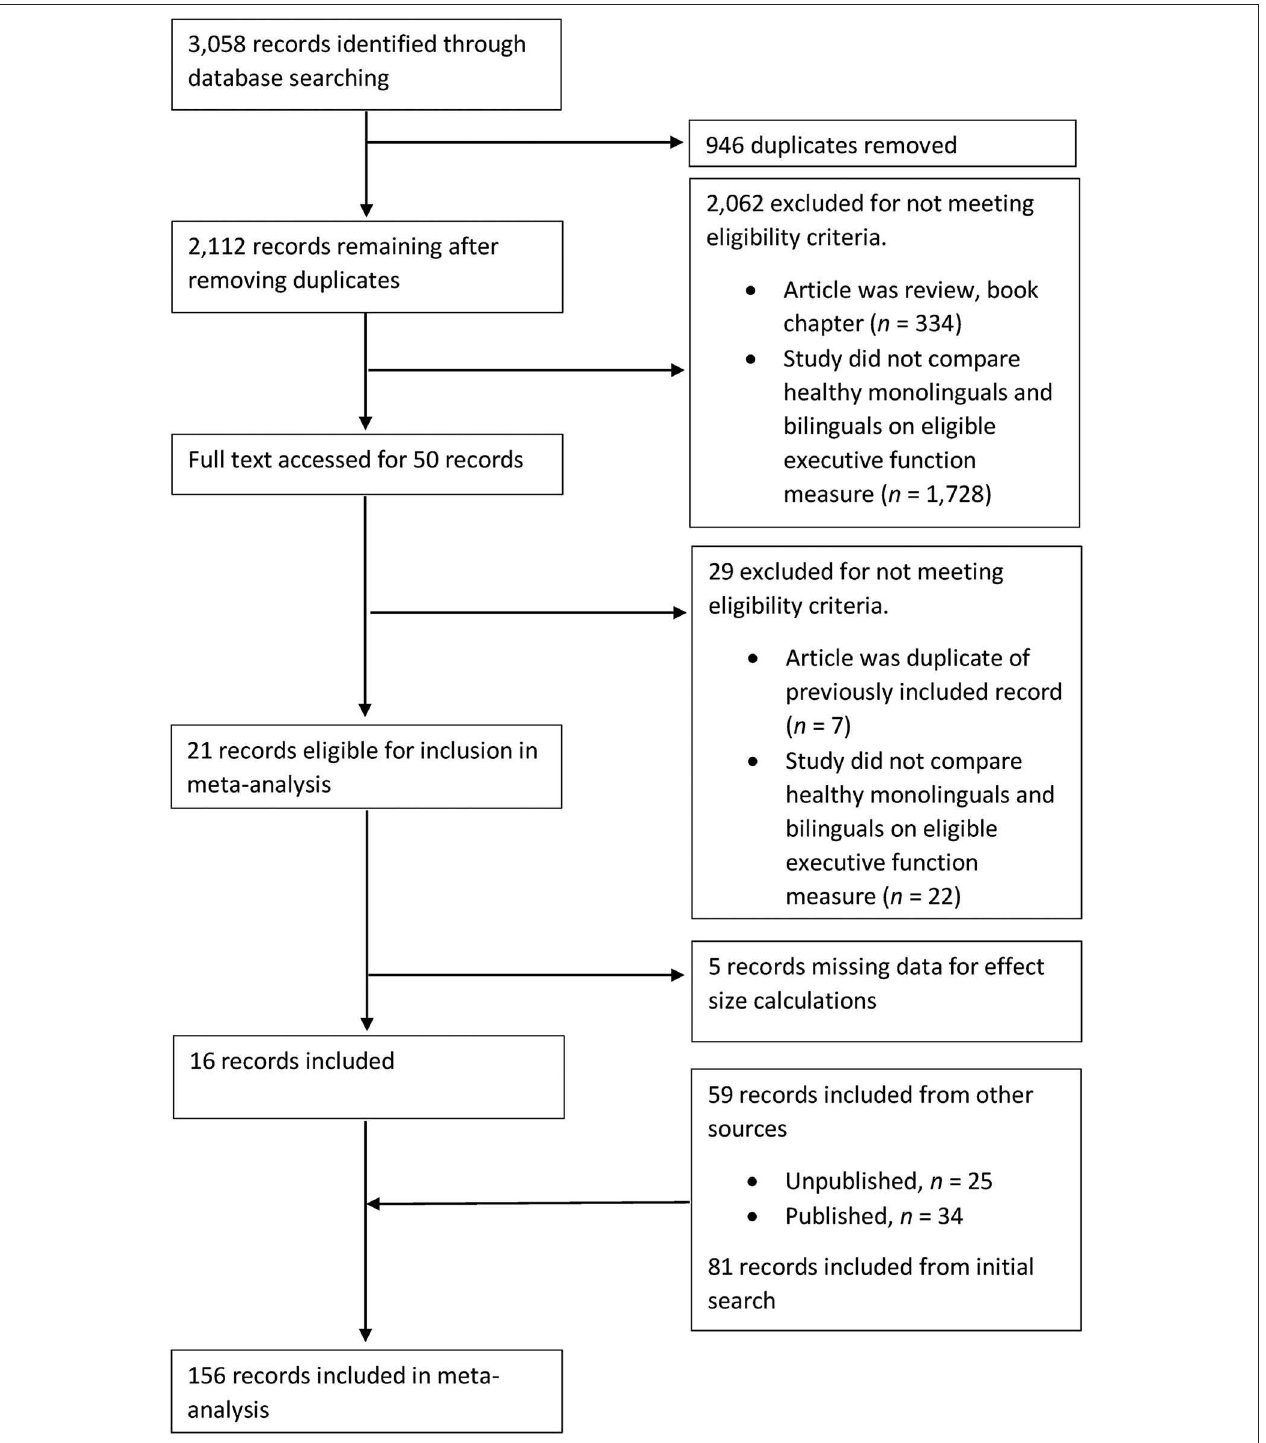
FIGURE 2 | PRISMA flowchart detailing the second search of the literature undertaken in March, 2018.